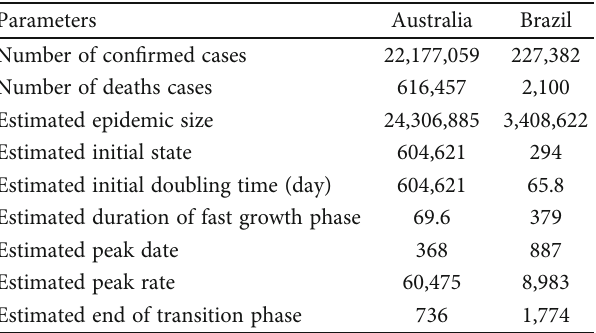
Table 4: Signi fi cant parameters of the logistic model to predict COVID-19.